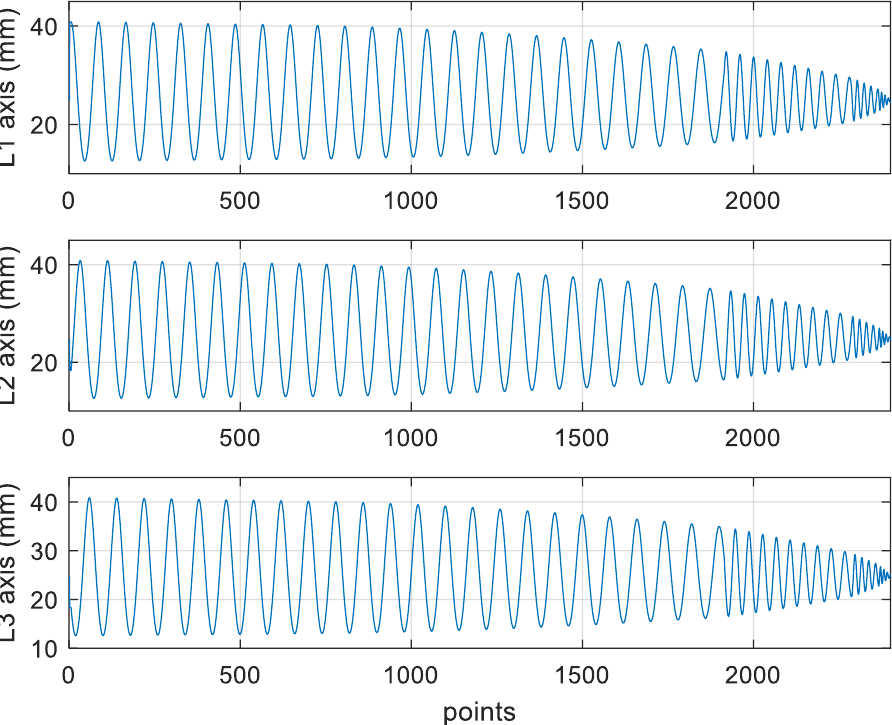
Figure 20. Three-dimensional image of the XYZ path after converting the rough machining pro- gram.